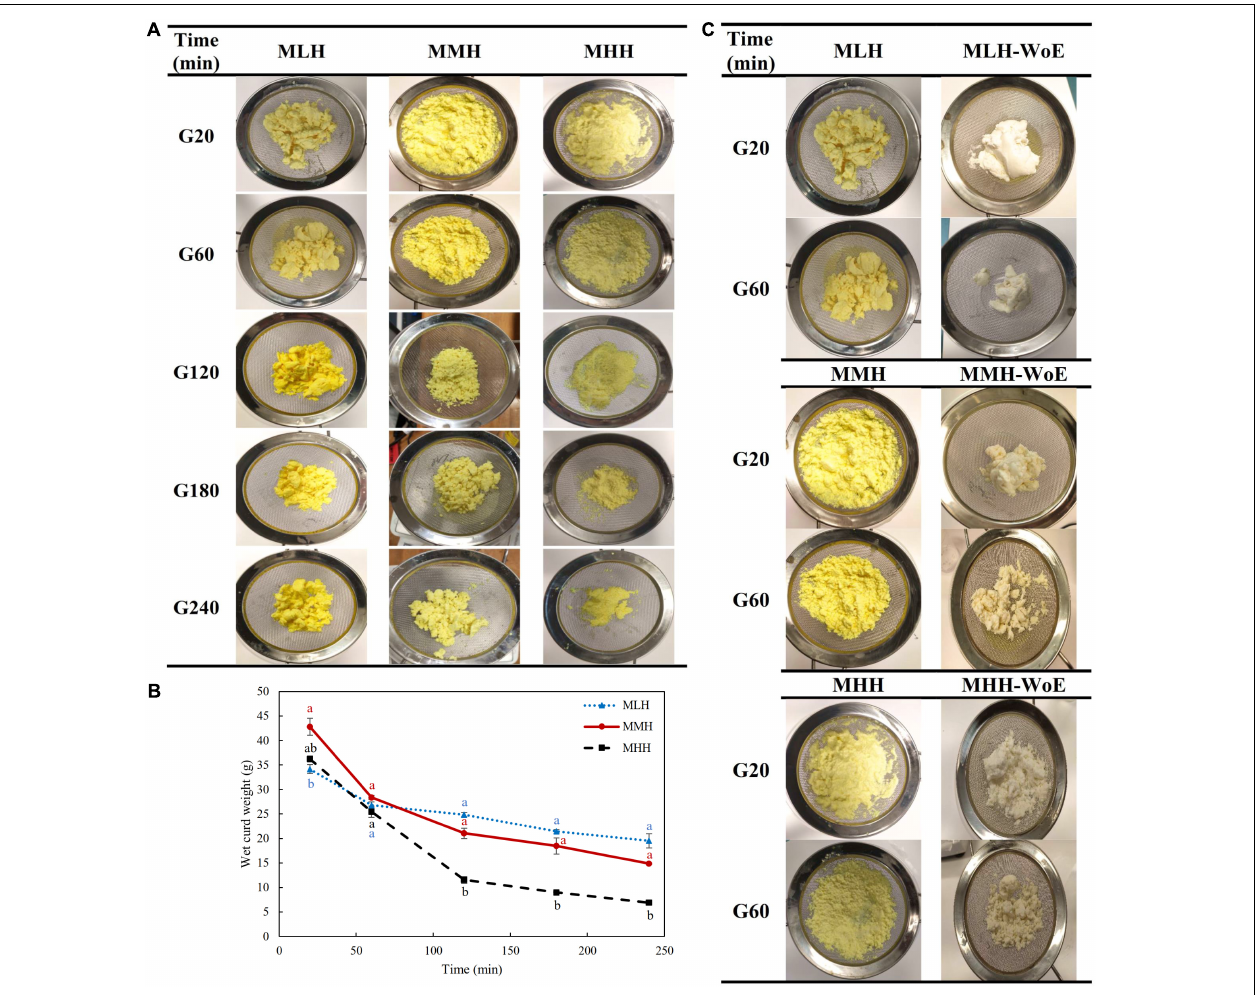
FIGURE 1 | (A) Images and (B) wet weights of the curds formed during the gastric digestion (simulated gastric fluid with pepsin) of 200 g of recombined milks with added curcumin nanoemulsion, i.e., low heat (MLH), medium heat (MMH) and high heat (MHH), at 20, 60, 120, 180, and 240 min of gastric digestion. (C) Comparison of the structures of the curds formed with and without curcumin nanoemulsion (WoE) at 20 and 60 min of gastric digestion.